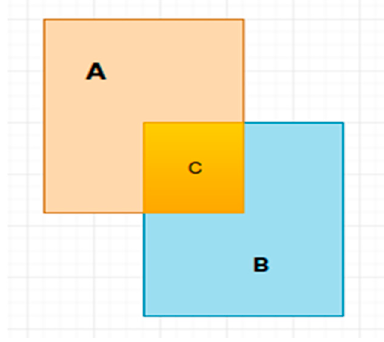
Figure 10. Intersection and union